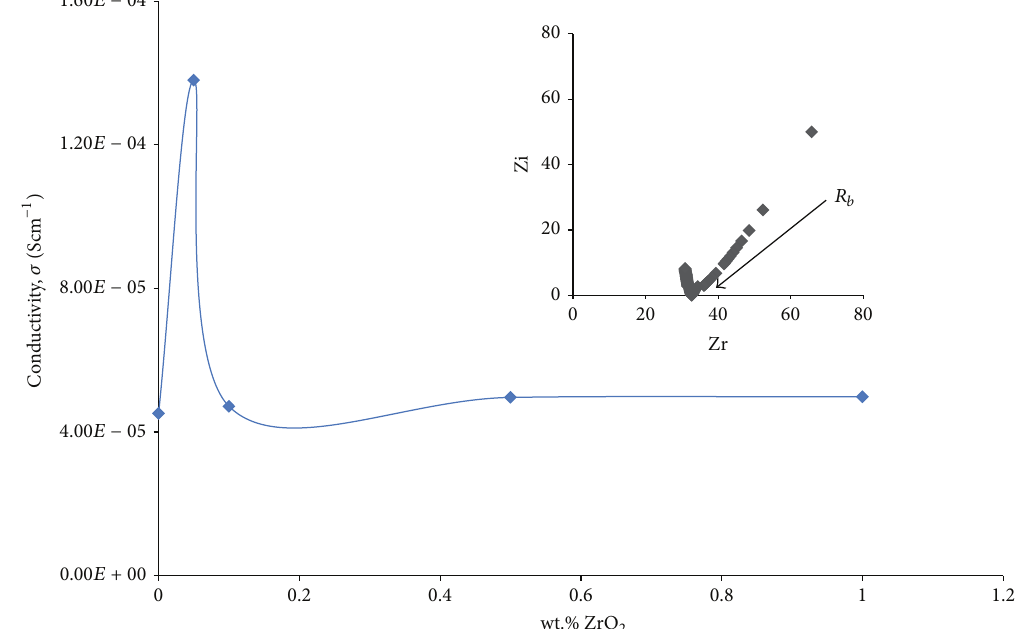
Figure 4: Ionic conductivities of SPE for various wt.% of ZrO 2 nanofiller and impedance plot for sample with the highest conductivity (inset).